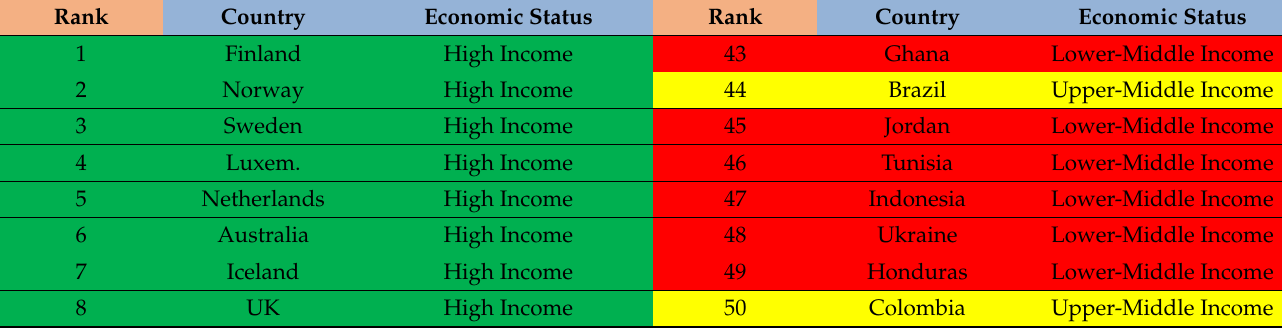
Table A1. World ranking on the basis of income